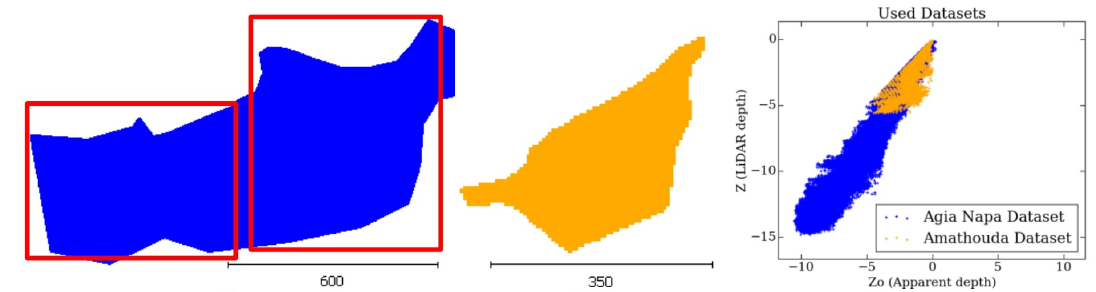
Figure 3. The two test areas from the Agia Napa test site are presented (left) with blue colour: Part I on the left and Part II on the right. The Amathouda test site is presented in the middle with orange colour. The distribution of the Z and Z o values for each dataset is presented (right) as well.